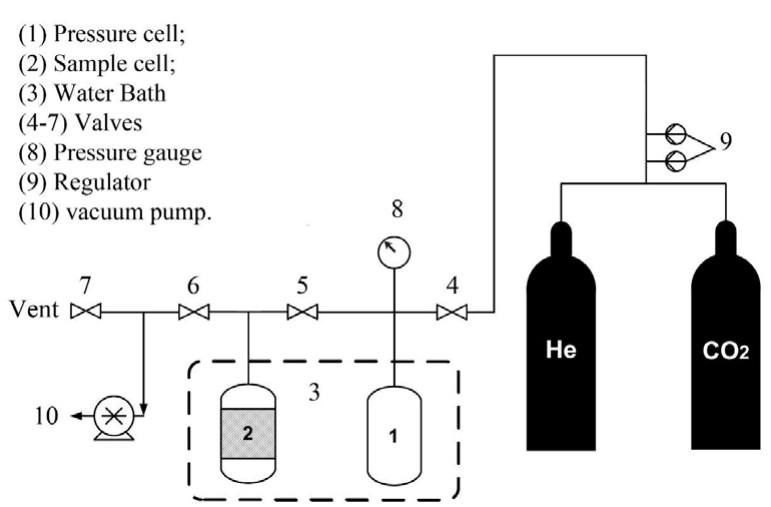
Fig. 2 Schematic diagram of the volumetric adsorption Fig.2 Schematic diagram of the volumetric adsorption apparatus.